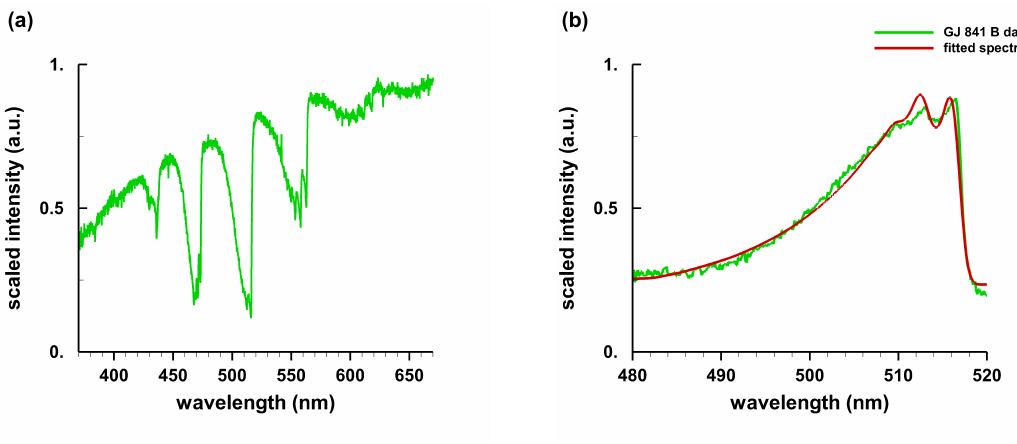
Figure 16. ( a ) C 2 Swan absorption spectrum from the white dwarf GJ 841 B [2]; and ( b ) inverted and fitted spectra for the ∆ v = 0 molecular bands. The fitted temperature amounts to T = 7.1 kK, and the fitted spectral width equals δλ = 1.8